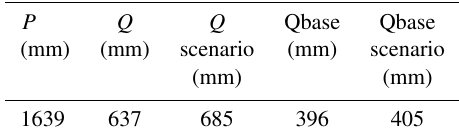
Table 1. Q results with SWAT for the land-use distribution and sce-